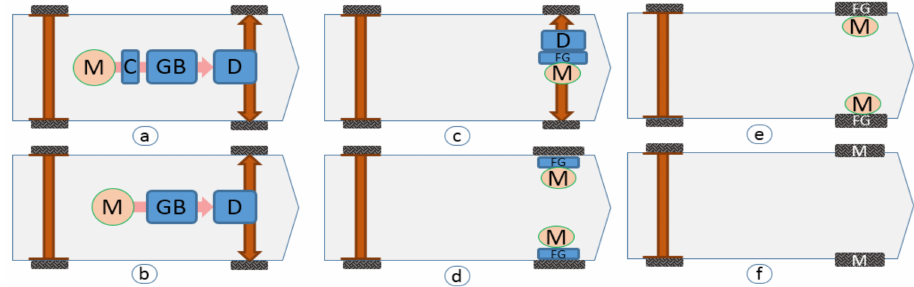
Figure 4. Different powertrain configurations of pure EVs: ( a ) primary architecture; ( b ) reduced architecture; ( c ) modern architecture; ( d ) dual motor architecture; ( e ) in-wheel architecture; ( f ) direct drive